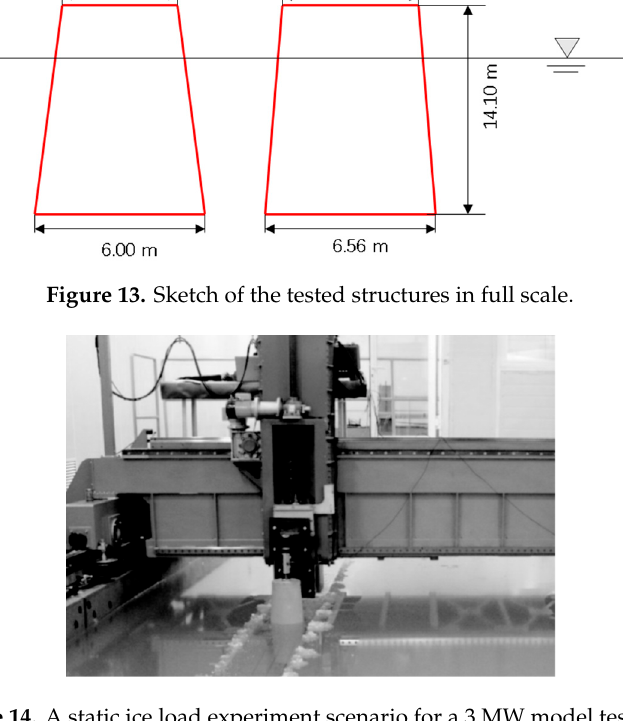
Figure 14. A static ice load experiment scenario for a 3 MW model test [30].